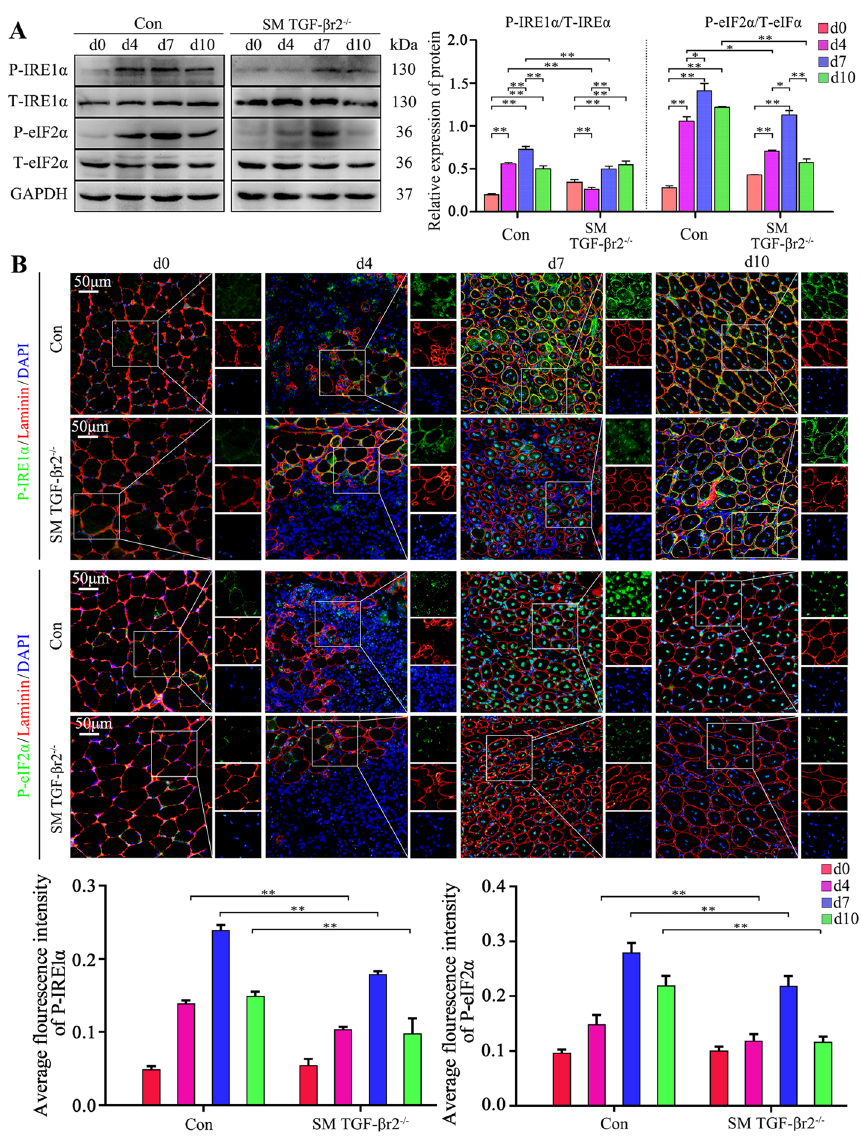
Fig. 6 Intrinsic TGF-β signaling effects on the activities of IRE1α and eIF2α arms of UPR in muscle cell. A The protein levels of IRE1α and eIF2α in damaged TA muscle from control or SM TGF-βr2 − / − mice were analyzed by Western blot. The relative protein expression values are expressed as a ratio [phosphorylated (P) protein/total (T) protein]. B Immunofluorescence staining and the quantitative results of IRE1α and eIF2α in damaged TA muscle. All data are presented as means SD ( n 3). A one-way ANOVA was used for multiple ± = comparisons (* P < 0.05; ** P < 0.01). Bar 50 =